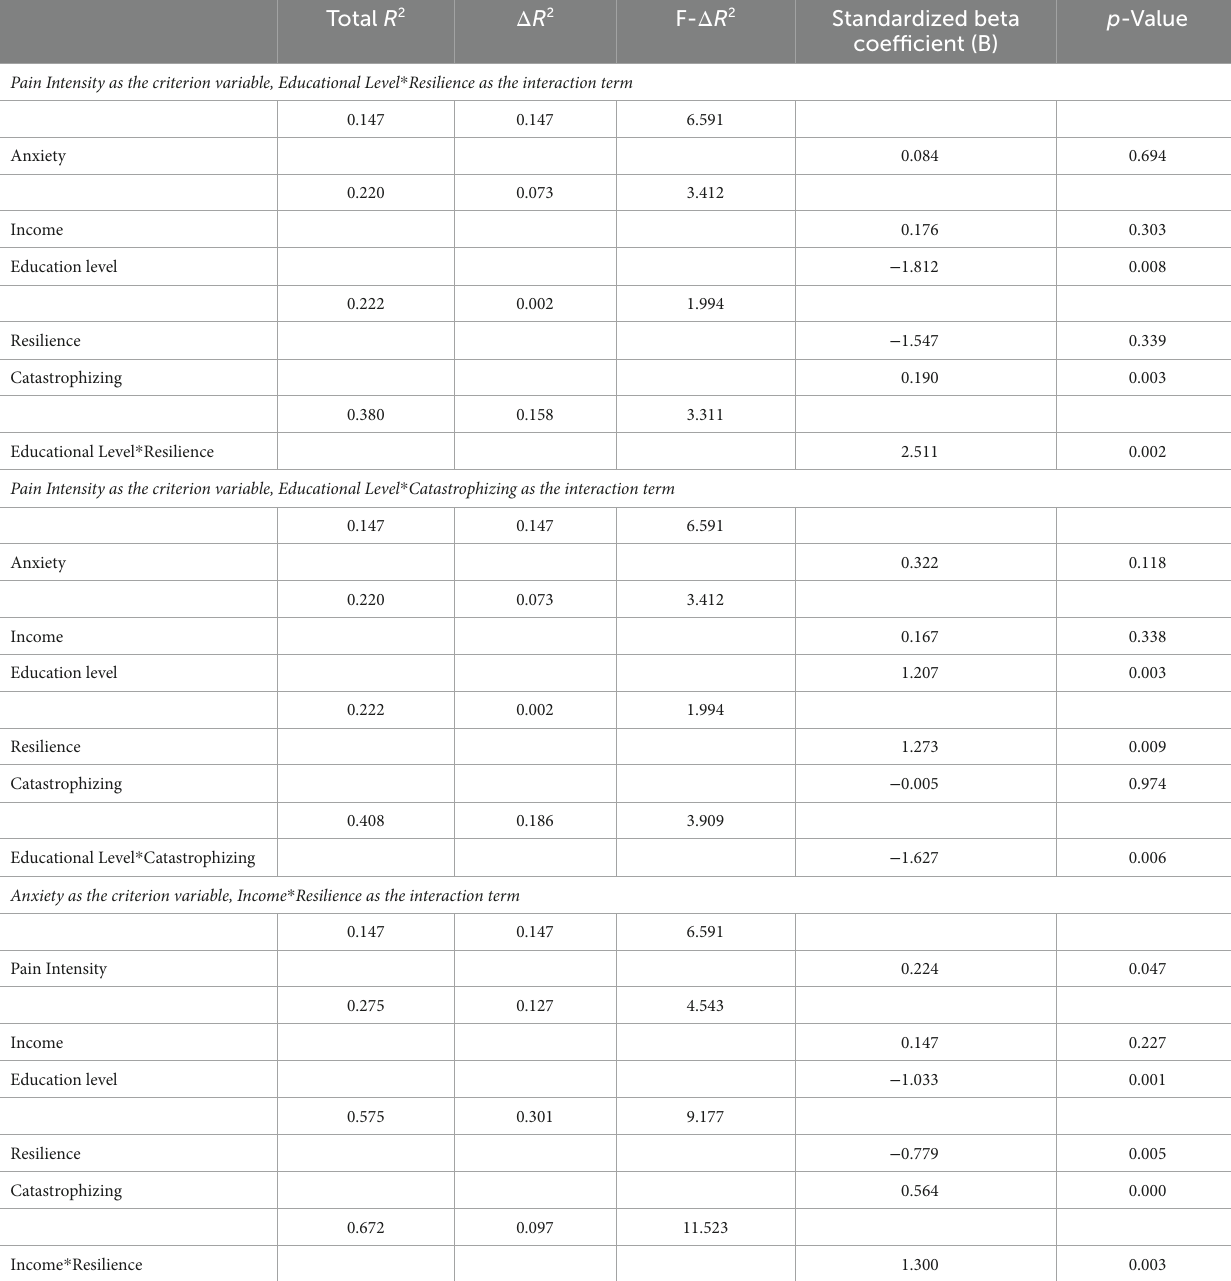
TABLE 4 The moderating effect of socioeconomic status on the relationship among pain intensity, psychological factors, and psychological